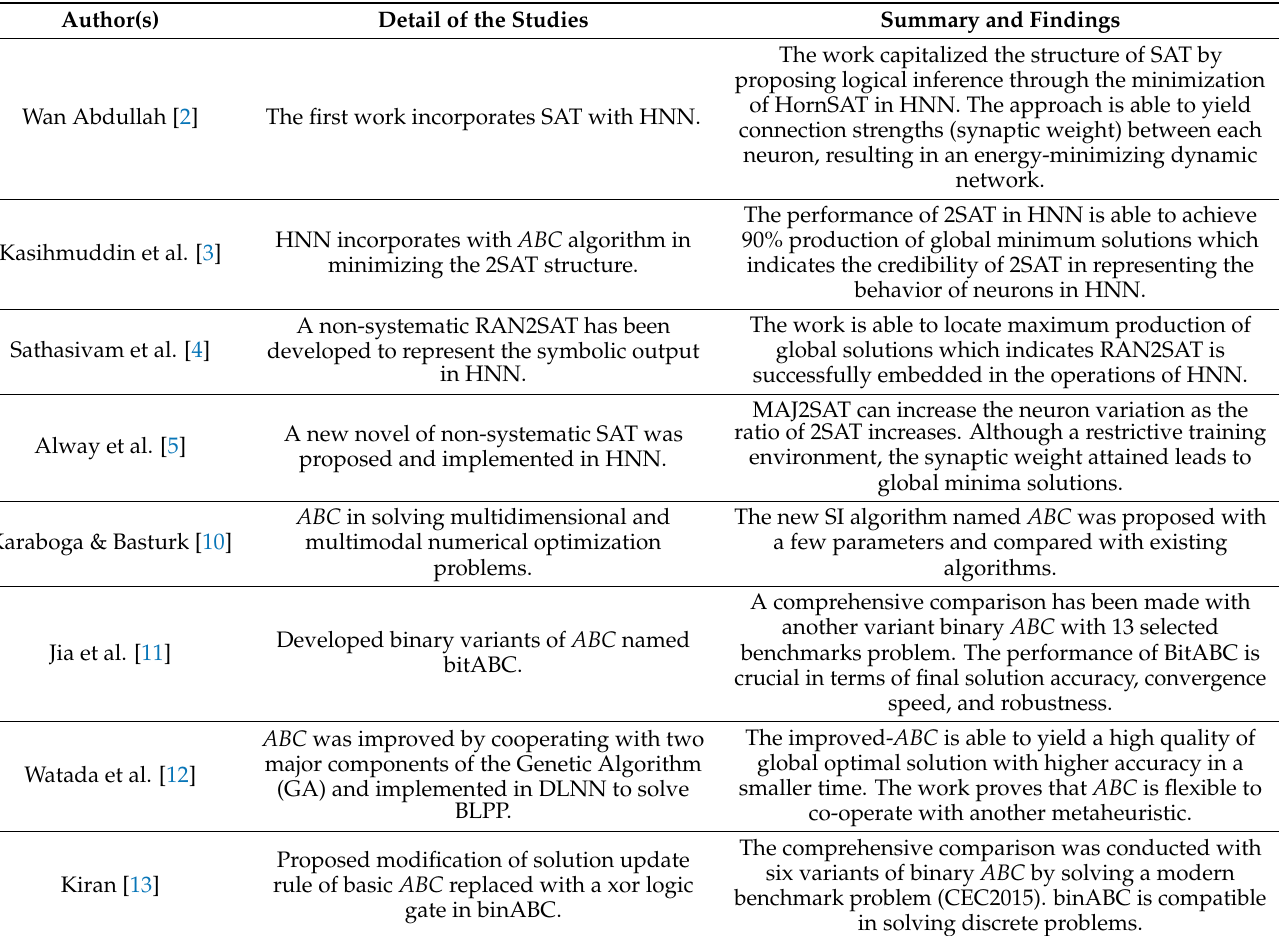
Table 1. Summary of the Related